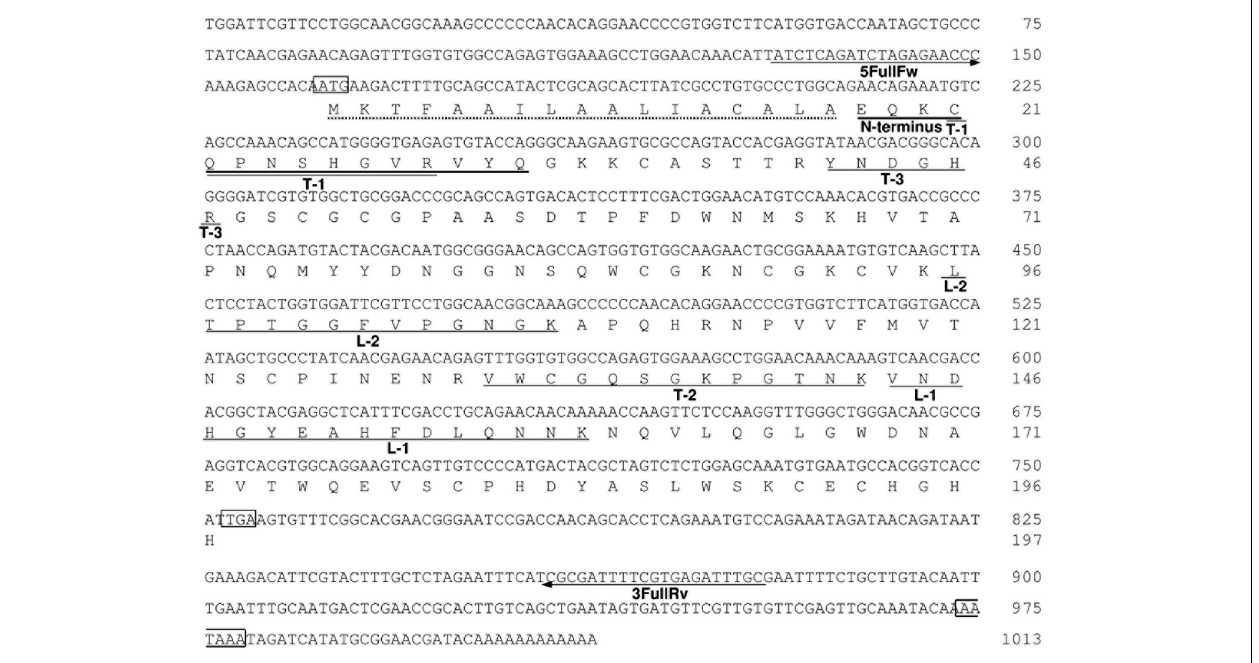
sequences determined with intact AkEG21 (N-terminus) and peptide fragments (L-1, L2, T1-T-3) are indicated with solid lines under the amino-acid sequence. The positions of 5FullFw and 3FullRv primers are indicated with arrows under the nucleotide sequence. The sequence data are available from the DNA Data Bank of Japan with an accession number,